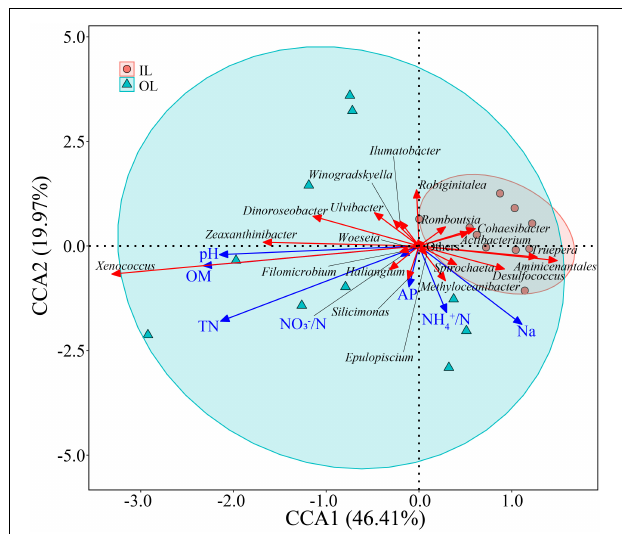
FIGURE 7 | Relationships between sediment microbial communities and environmental factors indicated by Canonical Correlation Analysis (CCA). IL (red circle) and OL (blue triangle) represent sediments from lagoon zone and surrounding area, respectively.